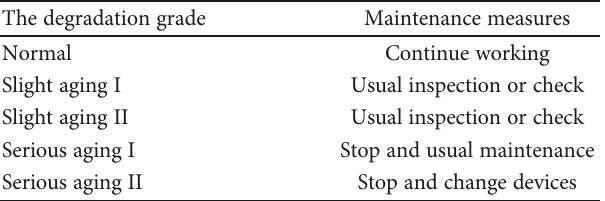
Table 5: Maintenance